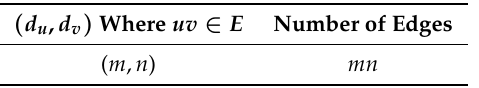
Table 10. Edge partition of K m , n on the basis of degrees of end vertices of each edge.